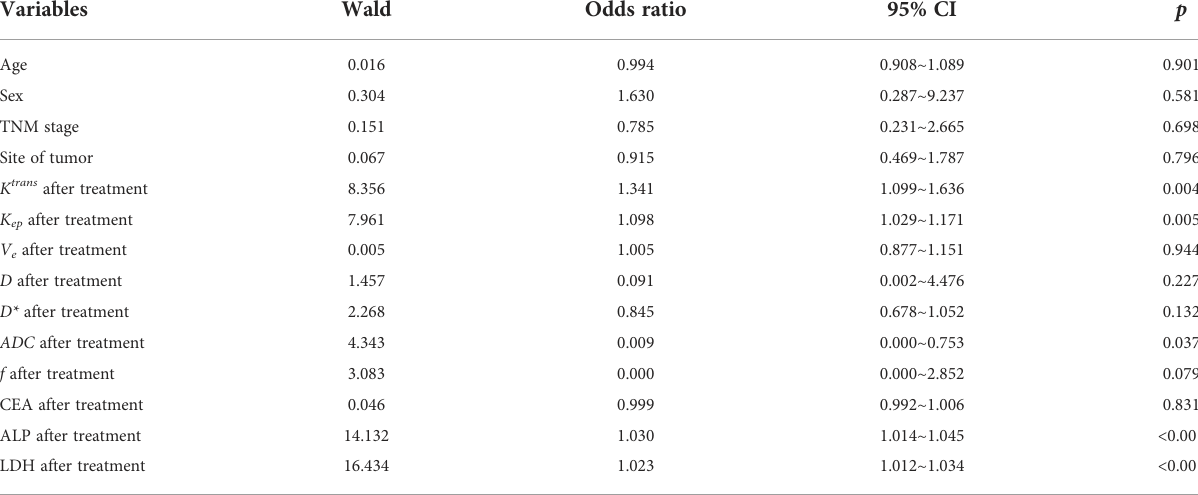
TABLE 3 Binary logistic regression for analysis of risk factor for PD of osteosarcoma after neoadjuvant chemotherapy. Variables Wald Odds ratio 95%